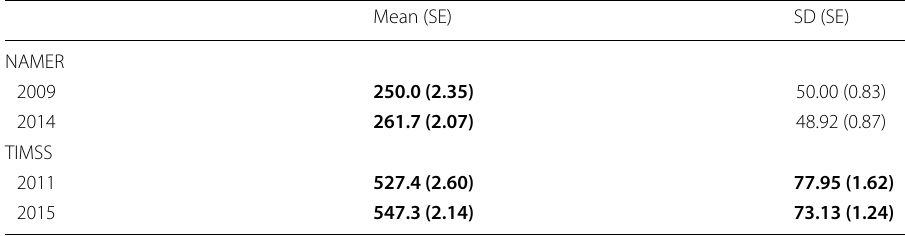
Statistically significant differences between cycles in